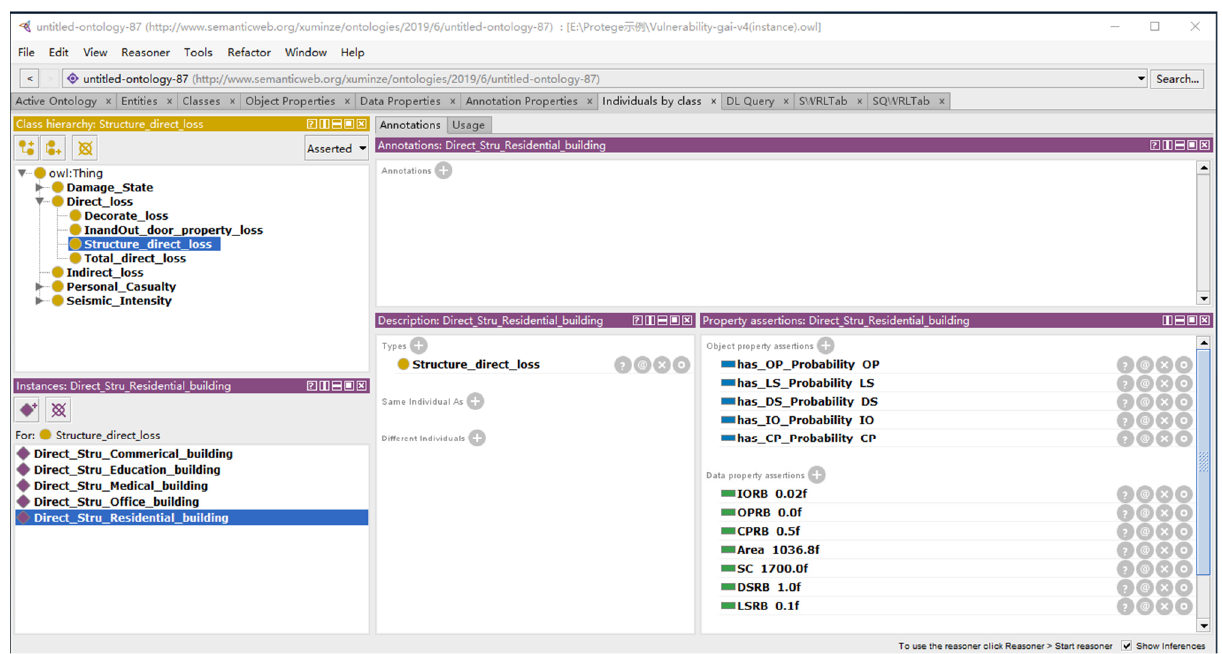
Figure 6. Create instances.